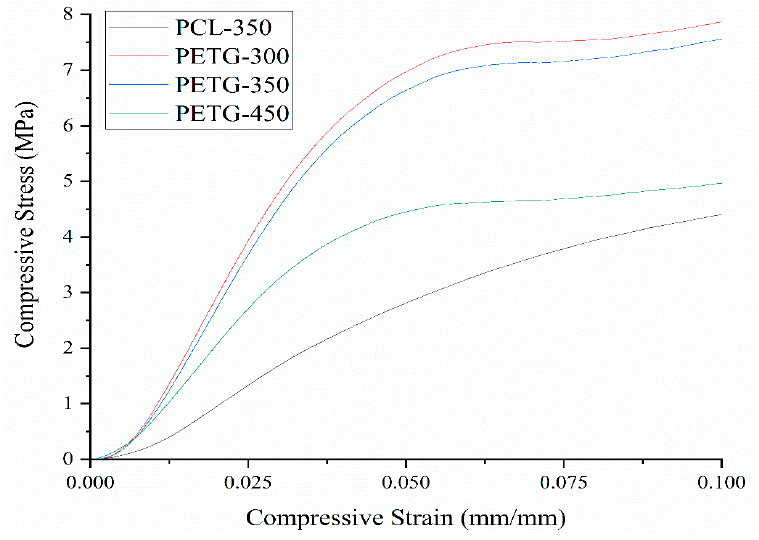
Figure 3. Stress vs. strain curves for PCL scaffolds and PETG scaffolds with different pore sizes.